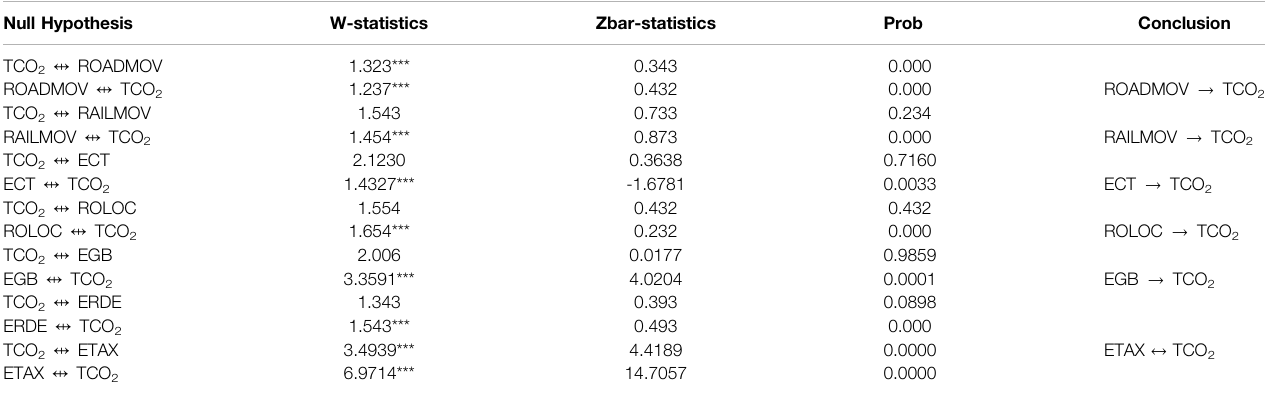
TABLE 9 | Panel Causality Test Results. Null